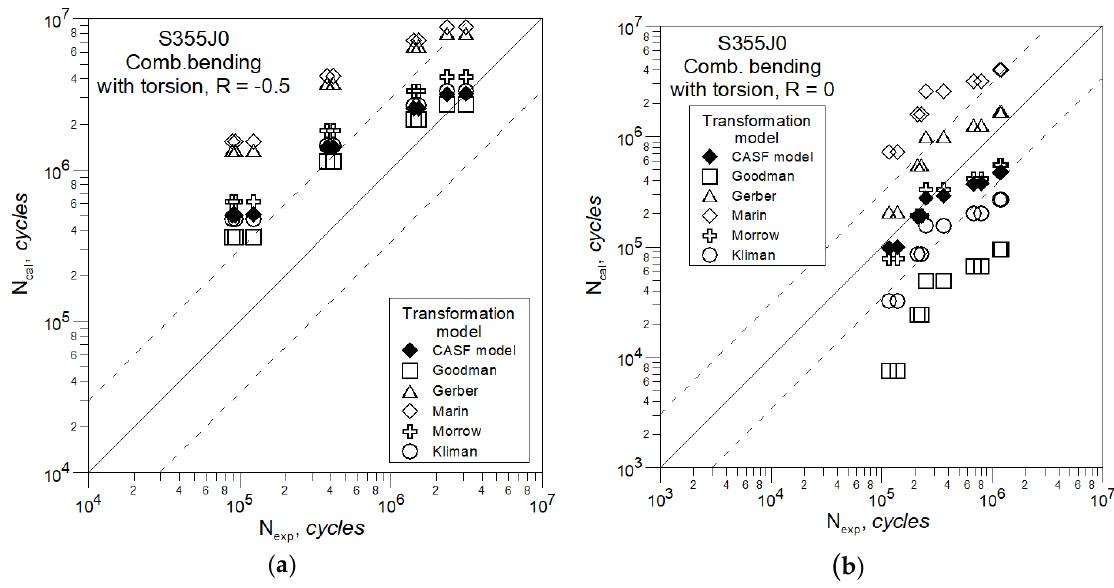
Figure 9. Comparison of the computational life N cal with the experimental N exp under torsion for: ( a ) R = −0.5, ( b ) R = −0.